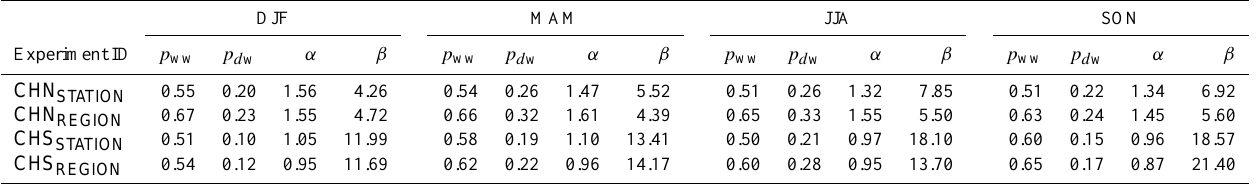
Fig. 2. Annual cycles of the multiplicative precipitation change signals (Synth 1P ) for the four experiments CHN STATION , CHS STATION , CHN REGION , CHS REGION estimated from time series pairs generated by a stationary first order Markov chain rainfall generator. The correct asymptotic solution is 1 representing no change. The dots indicate a specific realisation whereas the grey bands show the 10th–90th quantile range of 500 realisations. The precipitation change signals were estimated by moving averages (MA) based on averaging window widths of 15, 31, 61 and 91days over 30yr of daily data. Table 2. Seasonal parameter settings of the rainfall generator for the four experiments CHN STATION , CHN REGION , CHS STATION and CHS REGION . DJF MAM